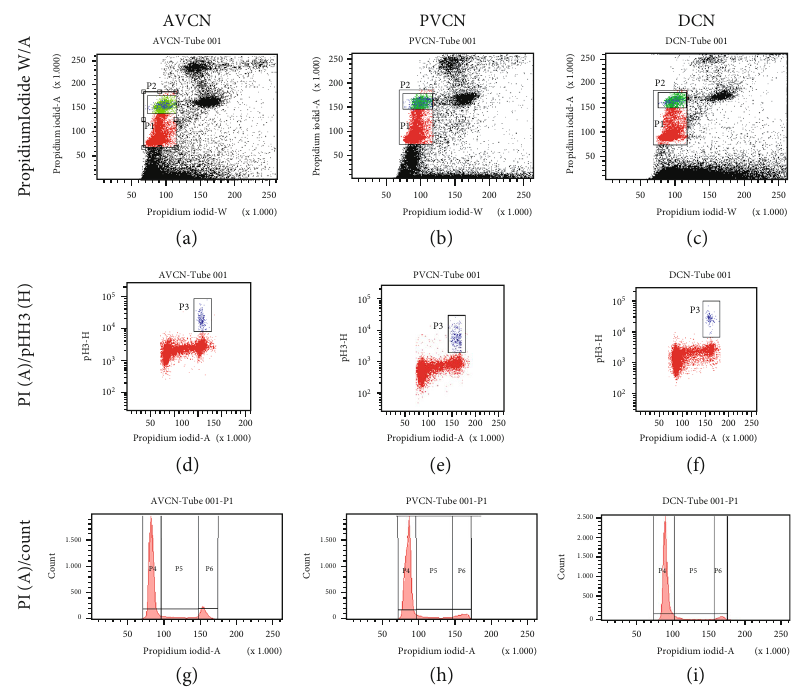
Figure 7: Representative illustration of the fl ow cytometry analysis with propidium iodide and anti-phospho-histone-H3 from AVCN, PVCN, and DCN NSCs. (a – c) Population of vital cells (P1) in the plot according to width by the area of propidium iodide ’ s fl uorescence intensity. P2 shows the population with double DNA content of the G2 and M phases. (d – f) Plot of the population of viable cells gated according to propidium iodide (width) by phospho-histone-H3 (height). P3 shows the population of viable cells with double DNA content — simultaneously stained positively with anti-phospho-histone-H3. (g – i) Histogram of the propidium iodide fl uorescence (height) in the viable cell population for quantifying the cell cycle: P4 corresponds to the G0/G1 phase, P5 corresponds to the S phase, and P6 corresponds to the G2 /M